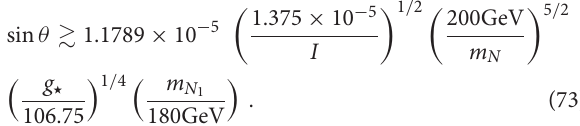
sin θ 0.1 (Red), 0.2 < sin θ ≤ ≤